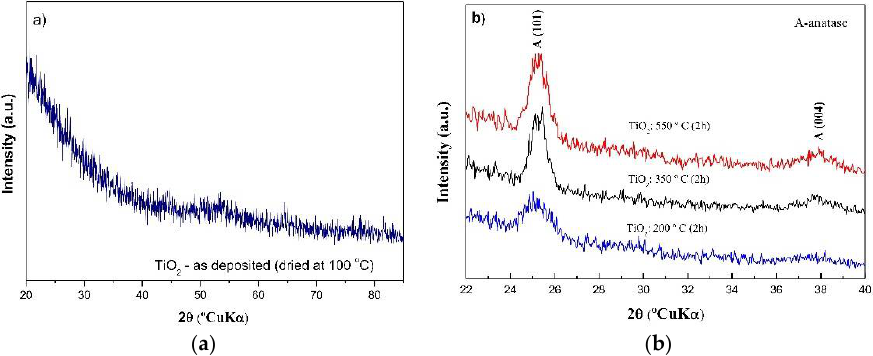
Figure 6. XRD patterns of pure TiO 2 films: ( a ) as-deposited and ( b ) heat-treated (from 200 °C up to 550 °C).